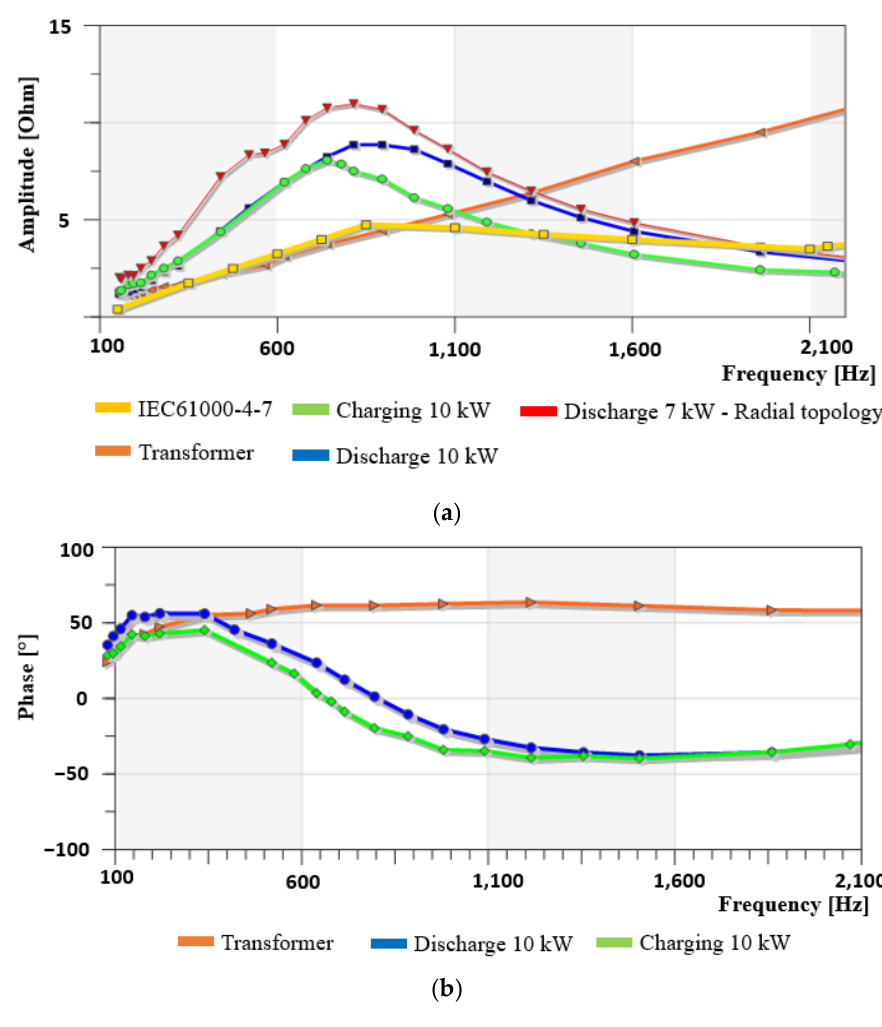
Figure 15. Amplitude ( a ) and phase angle ( b ) [15] of the grid impedance up to 2.1 kHz. The impedance graph at the distribution transformer station (orange) is up to 800 Hz similar to the impedance described in IEC61000-4-7 (yellow) [22] and shows ohmic-induc- tive behavior. The green line shows the impedance during charging and the blue line dur- ing discharging. It can be seen that the amplitudes of both are similar up to around 600 Hz and then the impedance during charging decreases by up to 2